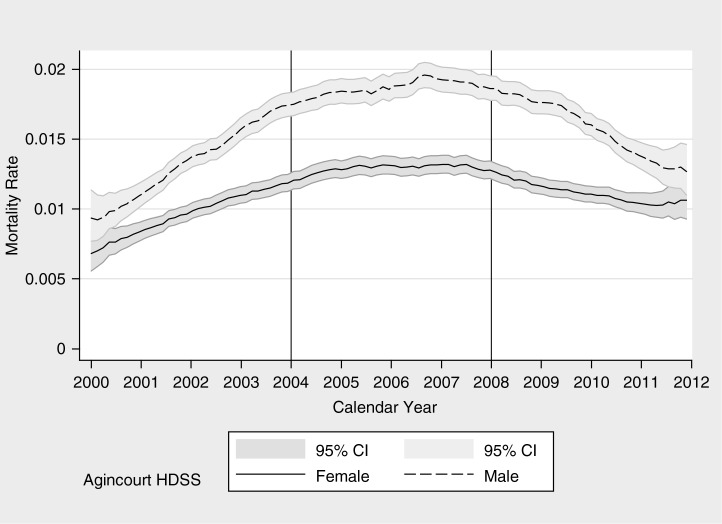
All-cause mortality rate by calendar year for males and females, Agincourt HDSS.